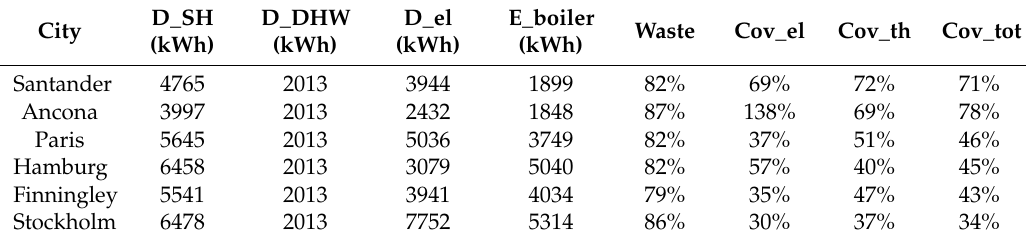
Table 6. Thermal performance of the Innova MicroSolar plant coupled with one single dwelling.